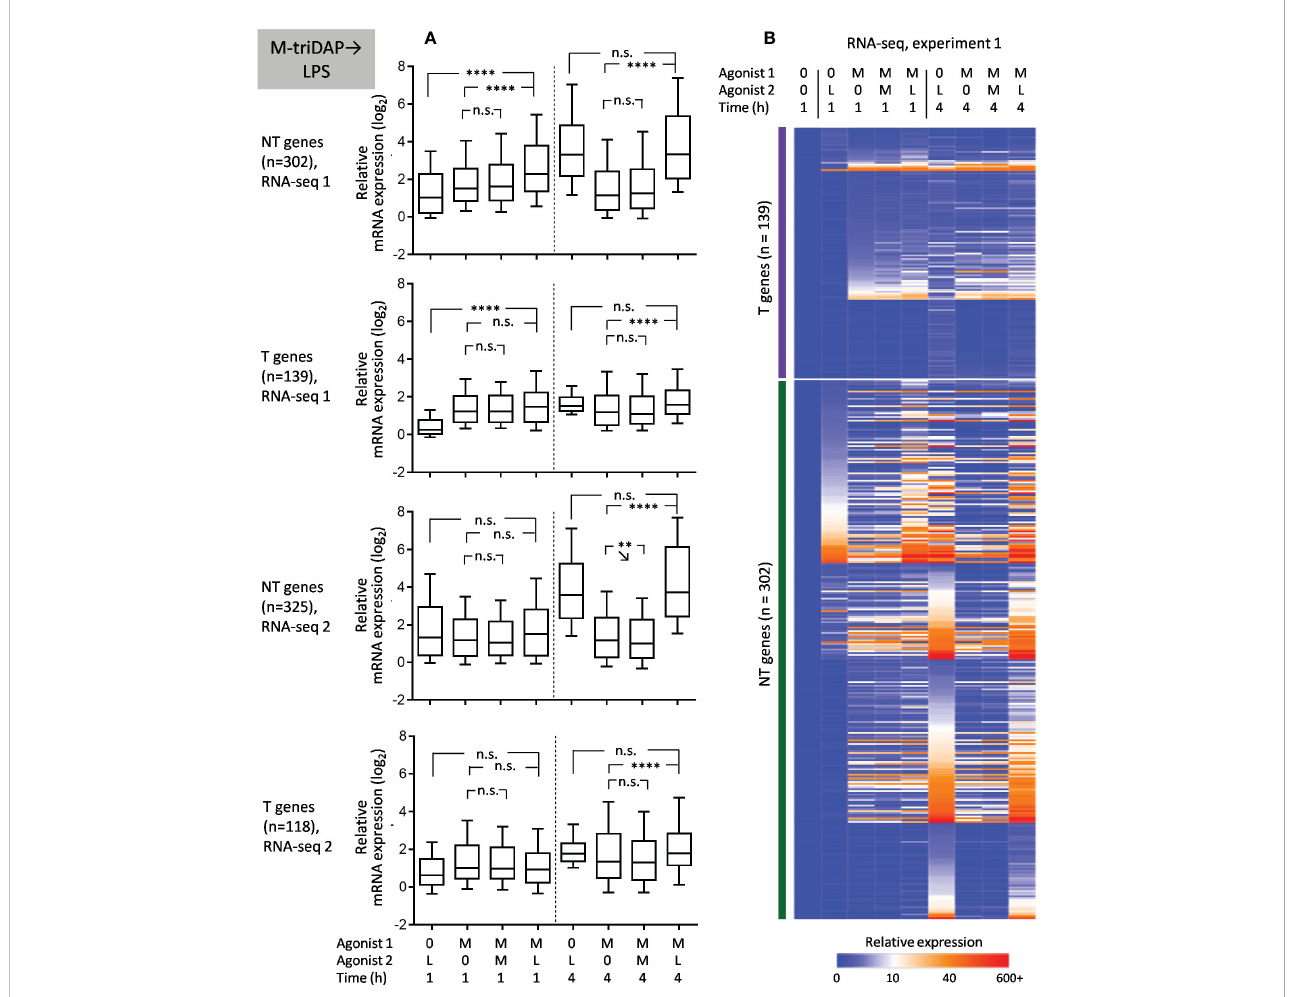
FIGURE 7 Responses of macrophages tolerized with M-triDAP (M) to stimulation with LPS (L). Only genes inducible in naïve macrophages both by M-triDAP and by LPS in both experiments after 1 and/or 4 h of stimulation are included (n = 446). (A) General statistics of T and NT gene expression in RNA-seq experiments 1 and 2 upon M-triDAP ➔ LPS stimulation. Responses of naïve macrophages to LPS (0 ➔ LPS), of M-triDAP-tolerized macrophages to M- triDAP (M-triDAP ➔ M-triDAP) as well as residual M-triDAP-induced expression (M-triDAP ➔ 0) are shown in parallel. (B) Heat map of relative gene expression from RNA-seq experiment 1. Statistical analysis as in Figure 2. **p < 0.01, ****p < 0.0001, n.s. = non-signi fi